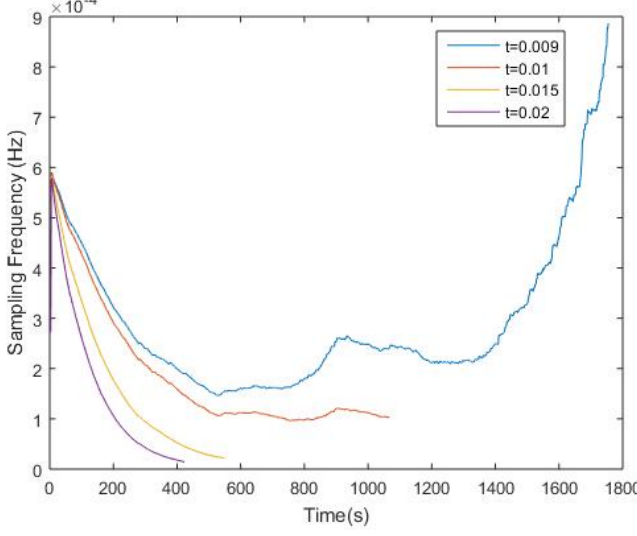
Figure 4. Frequency trend with t = 0.009, t = 0.01, t = 0.015and t = 0.02, respectively.